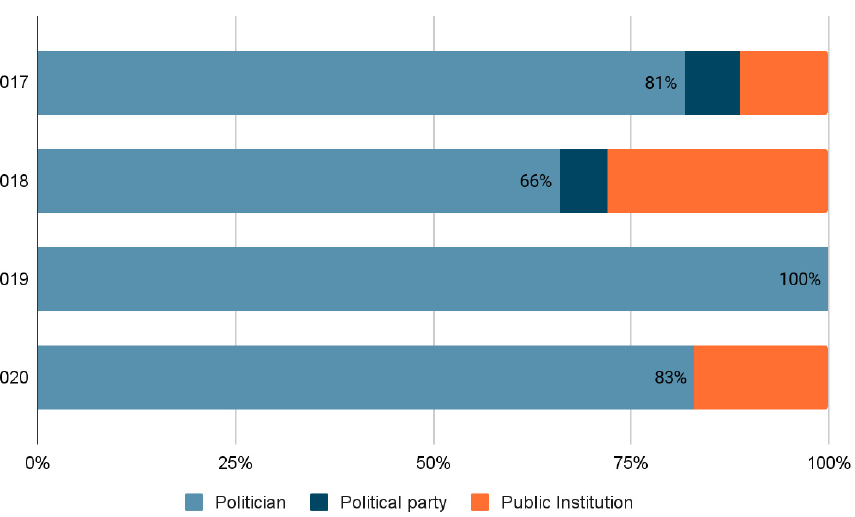
Figure 3. Percentages of political subcategories that the sample of Spanish deputies started to follow in 2017, 2018, 2019 and 2020.